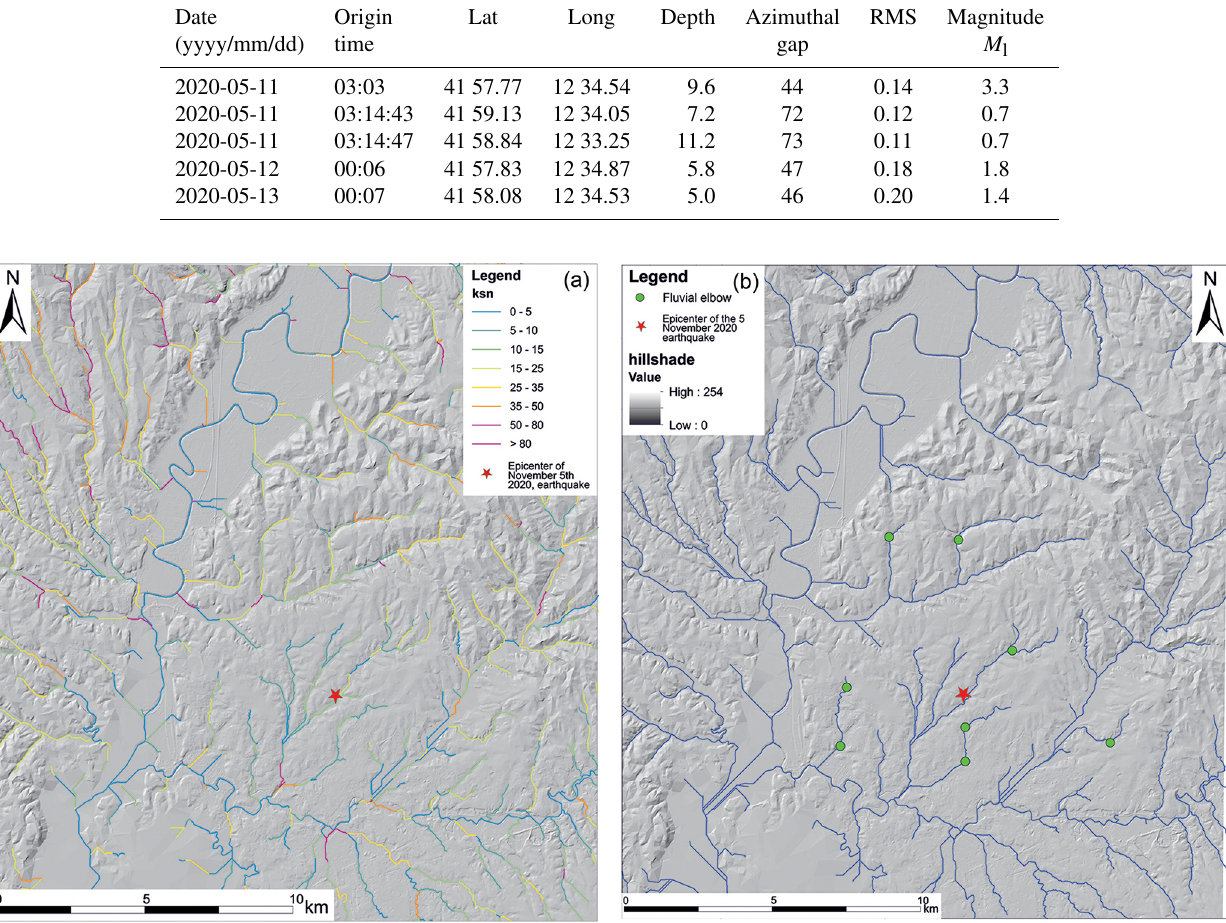
Figure 6. (a) Hillshade of the study area and distribution of the normalized channel steepness index (ksn, θ ref = 0.45). (b) Drainage network of the study area and main planar anomalies of the fluvial net. Tectonic lineaments inferred by morphotectonic analysis are also shown. Pub- lished with a CC BY 4.0 license by Istituto Nazionale di Geofisica e Vulcanologia (INGV), available at: https://doi.org/10.13127/TINITALY/